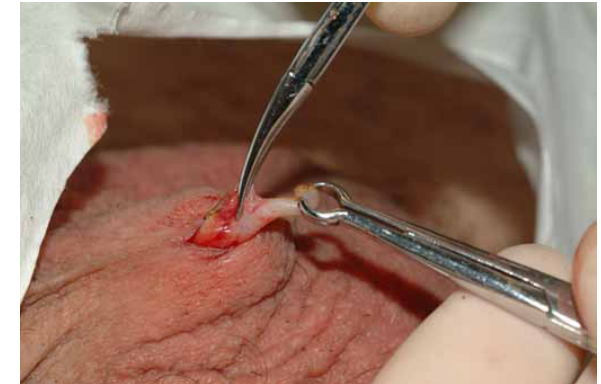
Figure 4 - Cauterizing the epithelium of the lumen of the prostatic segment of the vas.